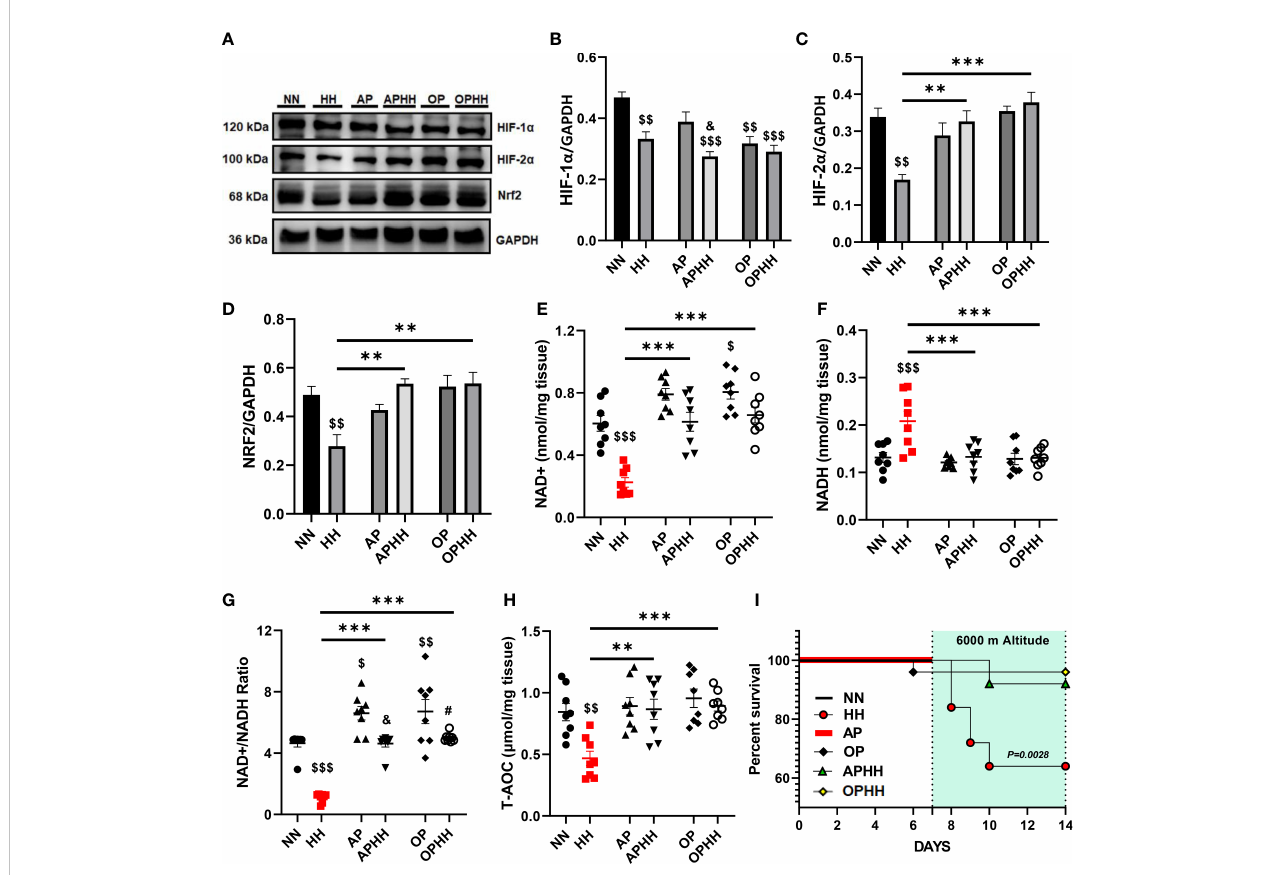
FIGURE 4 OP induces adaptive modulation of oxidative stress responses. (A-D) Representative Immunoblotting of Hypoxia-inducible factors (HIF)-1 a , HIF-2 a , and nuclear factor erythroid 2 – related factor 2 (Nrf2), and their respective Graphical plots; each blot band in the representative blot is an independent biological sample (n= 4 hearts per group). Normobaric Normoxia (NN), Hypobaric Hypoxia (HH), Altitude Preconditioned (AP), Altitude Preconditioned before HH exposure (APHH), Occlusion Preconditioned (OP), and Occlusion Preconditioned before HH exposure (OPHH) mice hearts. (E-H) Antioxidants state indexes; Graphical plots of the concentrations of redox cofactors, Nicotinamide adenine dinucleotide (NAD)+hydrogen (NADH) and their ratio, as well as the Total antioxidant capacity (T-AOC) of the myocardia (n=8 hearts per group). (I) Graphical plot of survival data in Kaplan-Meier estimator (n=18 mice per group). $ p<0.05, $$ p<0.01, $$$ p<0.001 HH vs NN; & p<0.05 APHH vs AP; # p<0.05 OPHH vs OP; ** p<0.01, *** p<0.001. Data are expressed as mean ± SEM. Data were analyzed using one-way ANOVA, followed by Tukey ’ s post hoc analysis. Survival curves were analyzed with the